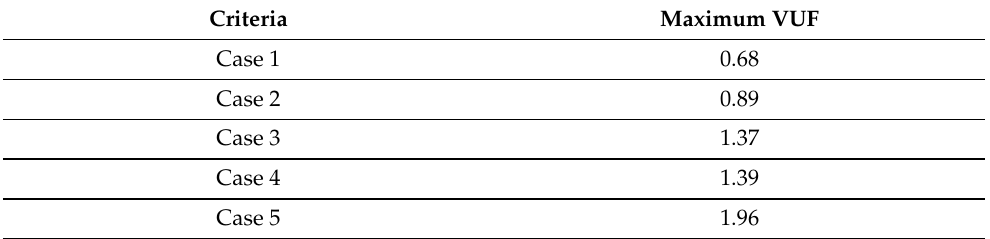
Table 5. Maximum VUF after using the proposed volt/var control